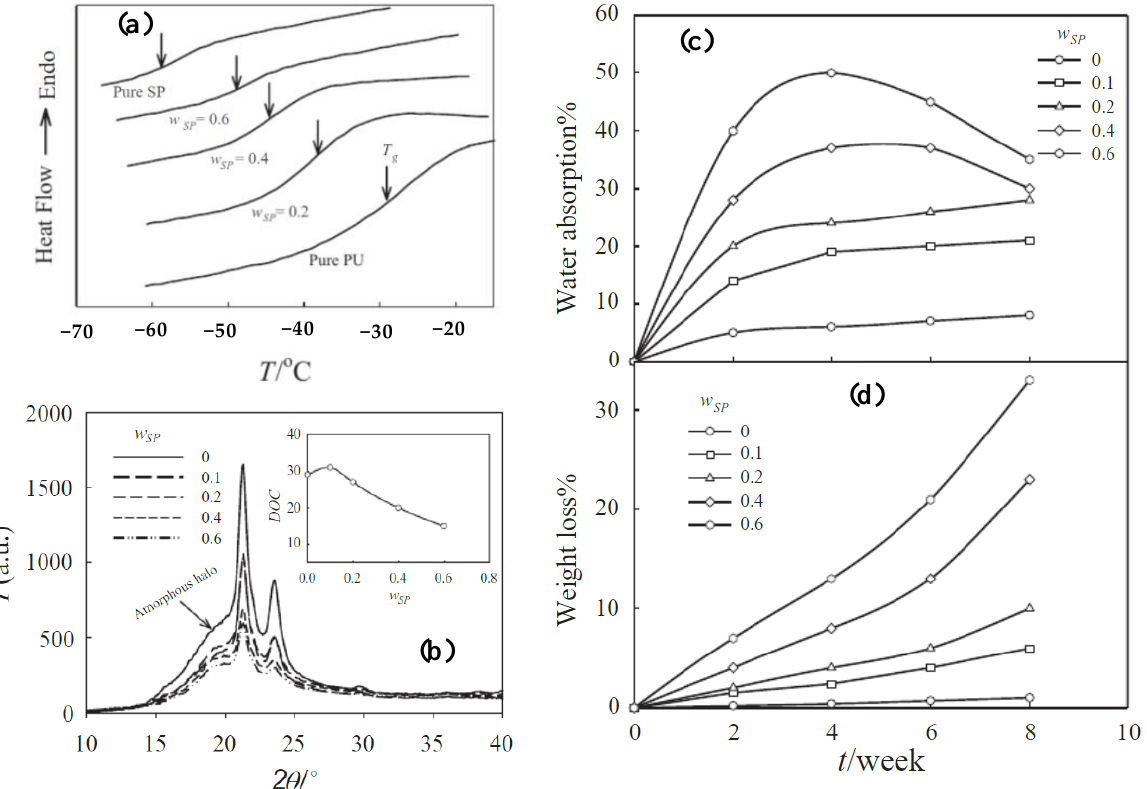
Figure 6. ( a ) DSC thermograms of second heating run for PU/soy protein (SP) blends of different compositions. The measurements were carried out at 10 ◦ C · min − 1 heating rate. The arrows denote the T gs for each composition. ( b ) WAXS patterns for PU/SP blends of different concentrations. Inset-plot shows the composition dependence of degree of crystallinity (DOC) for PU/SP blends calculated from the analysis of WAXS patterns. ( c ) Water absorption and weight loss percentages ( d ) of PU/SP blends as a function of degradation time in buffer solution of pH = 7.4 at 37 ◦ C (adapted with permission from [85]).